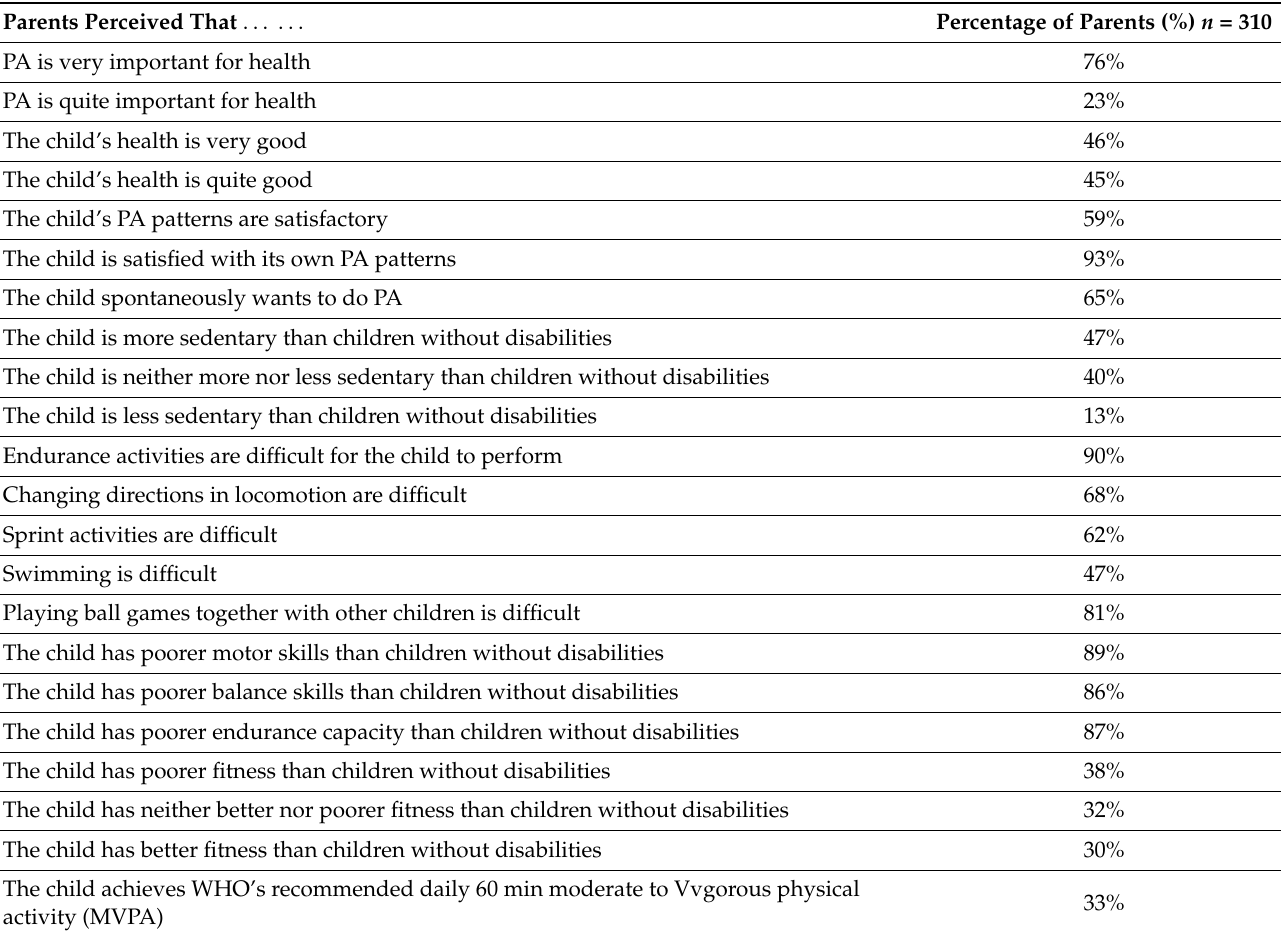
Table 2. Parents’ perceptions of physical activity (PA), the child’s health, the child’s PA patterns, the child’s willingness to do PA, the child’s sedentary behavior and difficulties in PA for the child (%). Parents Perceived That . . . . .